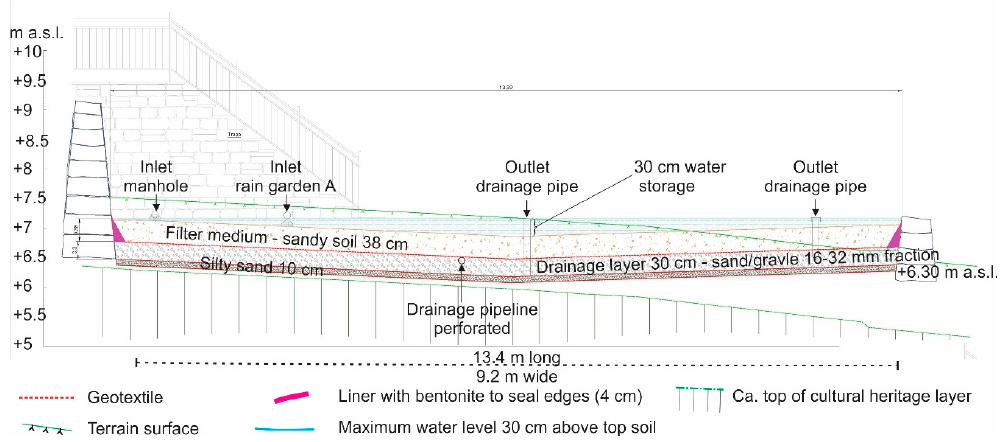
Figure 4. The design of rain garden B. Drawing: Multiconsult AS [21].